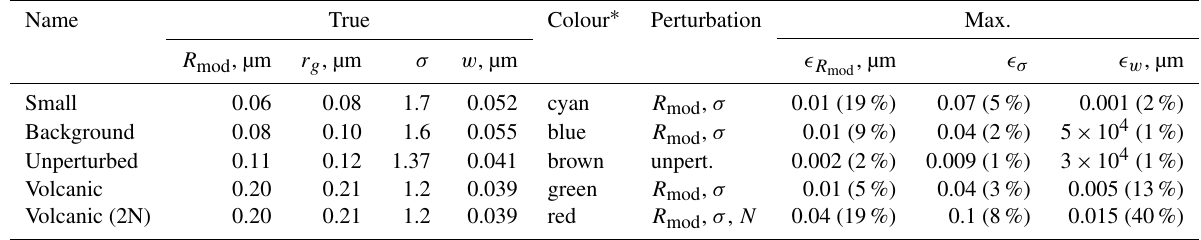
Table 1. Selected scenarios and associated maximum of absolute (relative) errors.